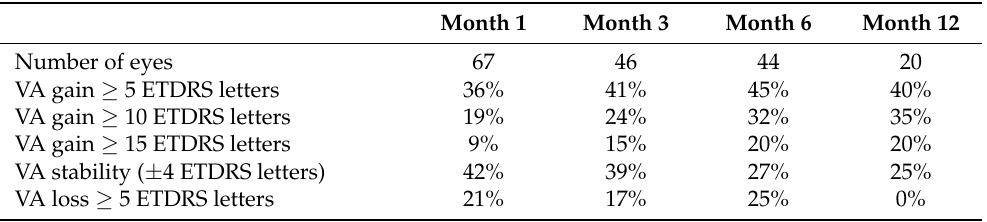
Table 3. Proportion of eyes with a visual-acuity gain or loss in ETDRS letters during the follow-up after fluocinolone acetonide implant injection. ETDRS, early treatment diabetic retinopathy study; VA, visual